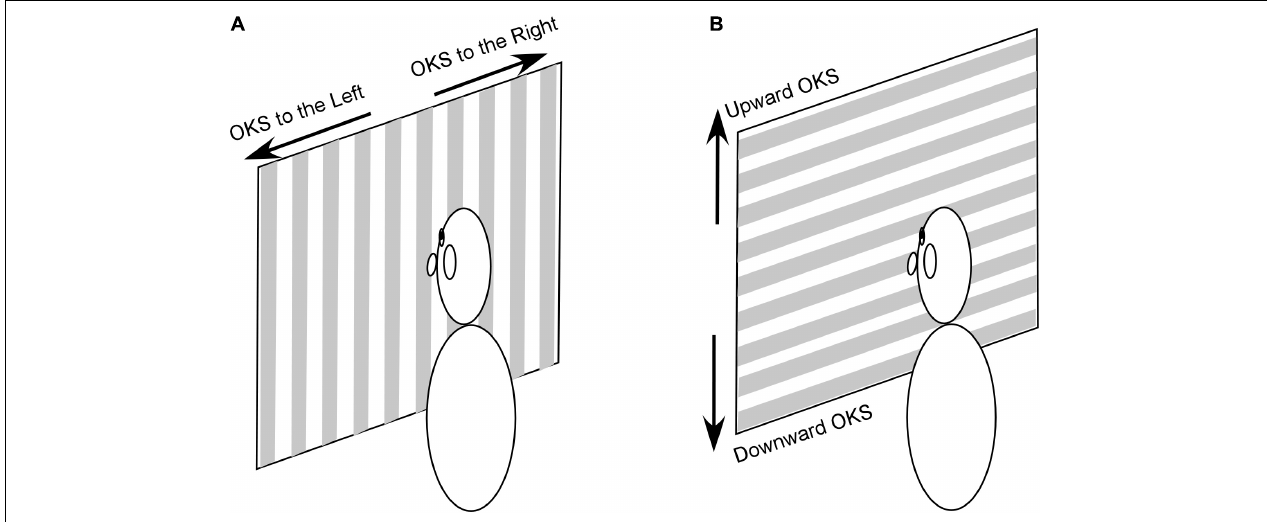
FIGURE 1 | OKS stimulation used to induce horizontal (A) and vertical (B) optokinetic nystagmus. It should be noted that the chamber wall is cylindric and stripes in (A,B) are curved and wider at the periphery. See text for a detailed description of the